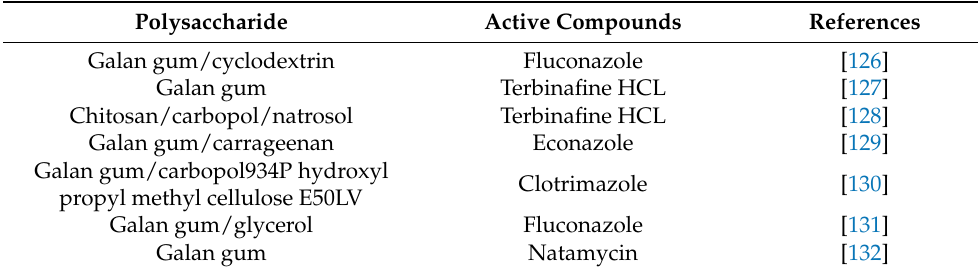
Table 6. Existing antifungal drug-loaded polysaccharide-based formulations.